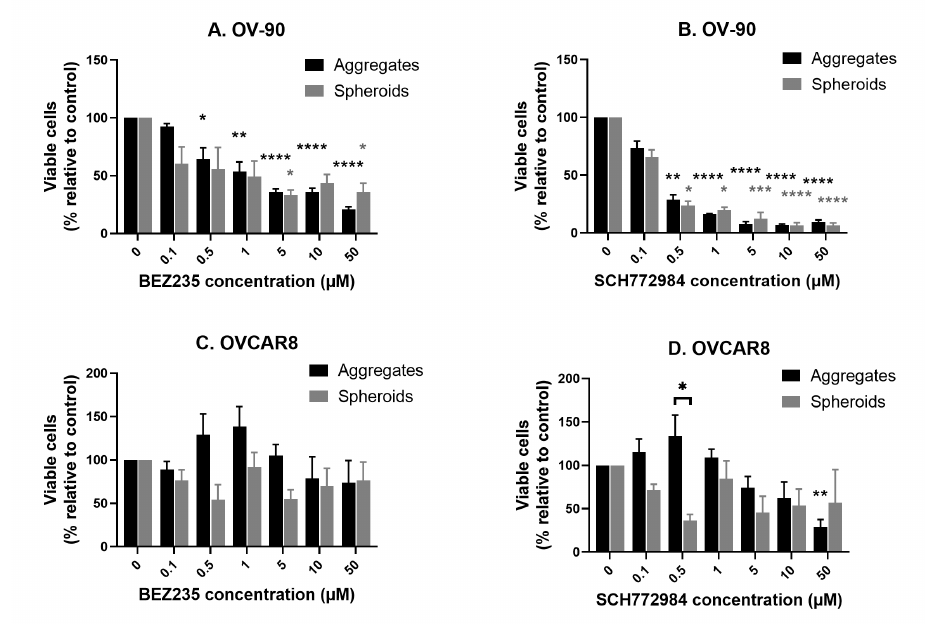
Figure 6. The effect of the PI3K/mTOR inhibitor BEZ235 and the ERK inhibitor SCH772984 on proliferation in OV-90 ( A , B ) and OVCAR8 ( C , D ) aggregates and spheroids. BEZ235 significantly reduced proliferation at concentrations of 0.5 µ M and above in OV-90 aggregates and at 5 and 50 µ M in OV-90 spheroids ( A ) but did not reduce proliferation in OVCAR8 aggregates or spheroids ( C ). SCH772984 significantly reduced proliferation at concentrations of 0.5 µ M and above in OV-90 aggregates and spheroids, respectively, ( B ) and at 50 µ M in OVCAR8 aggregates ( D ) but did not significantly effect proliferation in OVCAR8 spheroids. Cultures were established for 7 days prior to 72 h of exposure to the inhibitors. Data are expressed as mean ± SEM (n = 4). Statistical significance is at p < 0.05 and is in comparison to the control. The statistically significant differences are indicated as p < 0.05 (*), p < 0.01 (**), p < 0.001 (***) and p < 0.0001 (****), as determined by one-way ANOVA with Dunnett’s multiple comparison test on log transformed data. Any statistically significant differences between treatment groups is indicated by horizontal significance